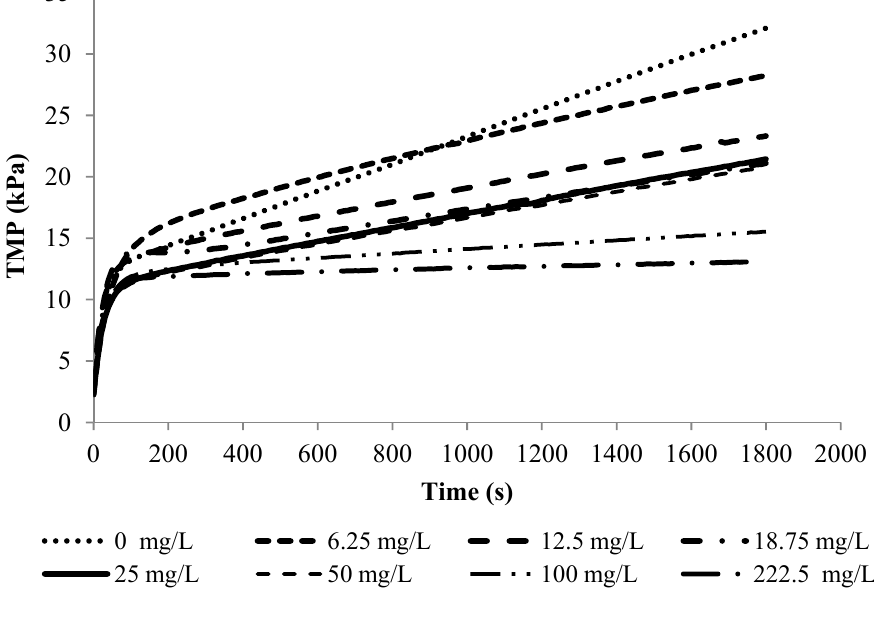
Figure 3. TMP profiles for experiments with 10 mg/L SA and 2 mM NaHCO 40